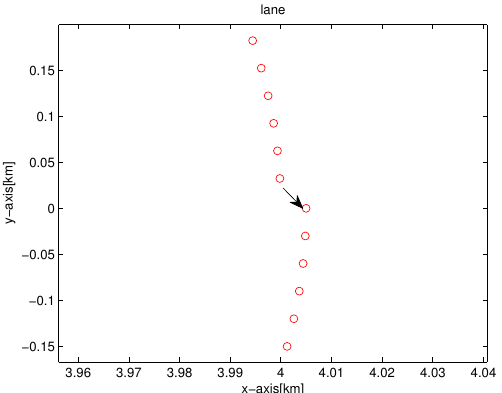
red circles. Simulations handle the case where the leader changes its lane to avoid obstacles. See that waypoints jump from one lane to another. The jump is marked with an arrow in this figure.